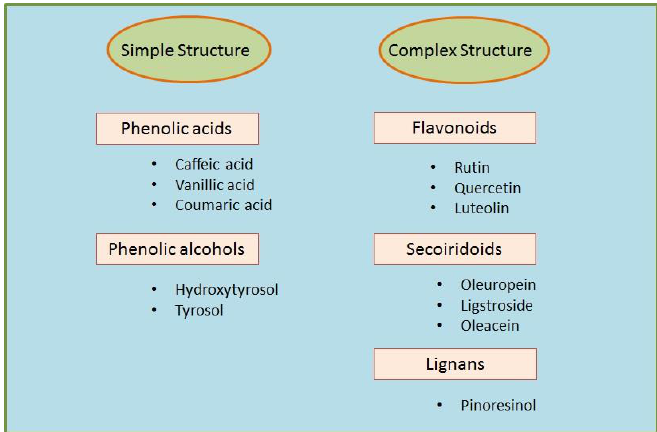
Figure 2. Classification of olive tree biophenols and most representative compounds.